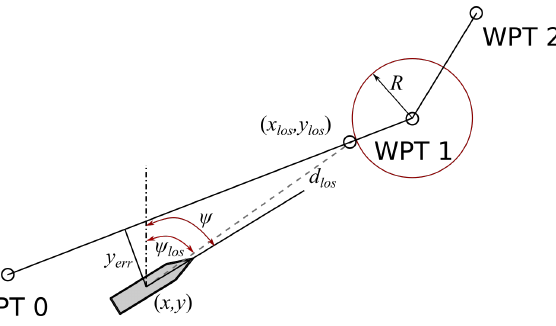
Figure 6. Ship’s position fixing in relation to the reference